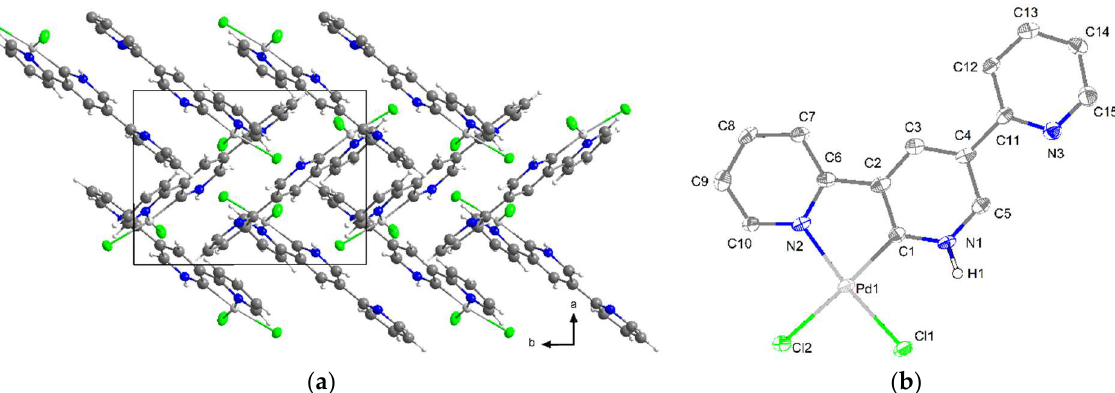
Figure 3. View of the crystal structure of [Pd(2,3′:5′,2″-terpyH)Cl 2 ] ( Pd-H2-Cl 2 ) along the c -axis ( a ) and ORTEP plot of the molecular structure with displacement ellipsoids at 50% probability; H atoms were omiTed for clarity ( b ).